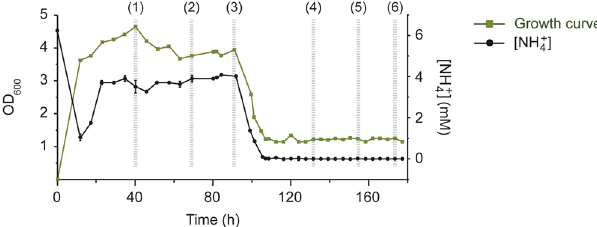
Figure 2. Growth of P. ruminicola 23 in continuous culture shifting from excess ammonium (10 mM) to limiting conditions (0.7 mM), and residual ammonium concentration in culture medium. Higher ammonium concentrations yielded higher ODs in comparison with growth–limiting conditions. Growth was measured by determining average optical densities at 600 nm (OD 600 ) in triplicate. Error bars represent standard deviations.